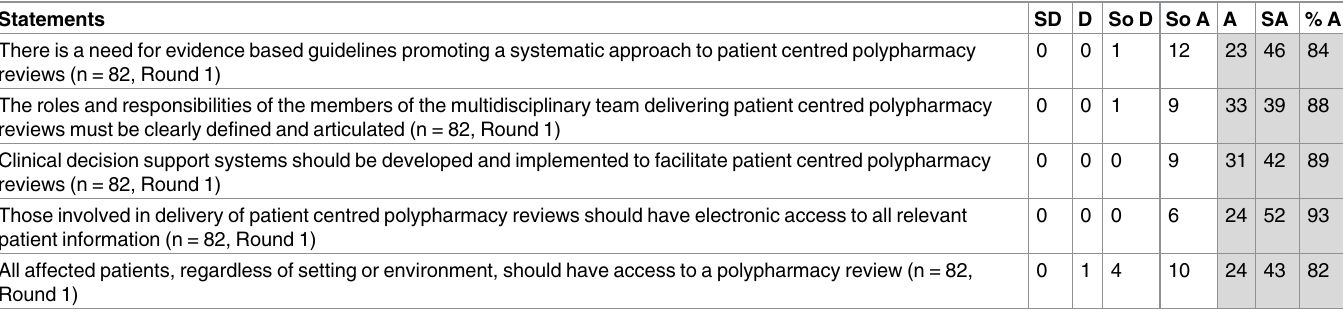
Table 8. Number of responses and % agreement(strongly agree/agree) to statements relating to patient centred polypharmacy